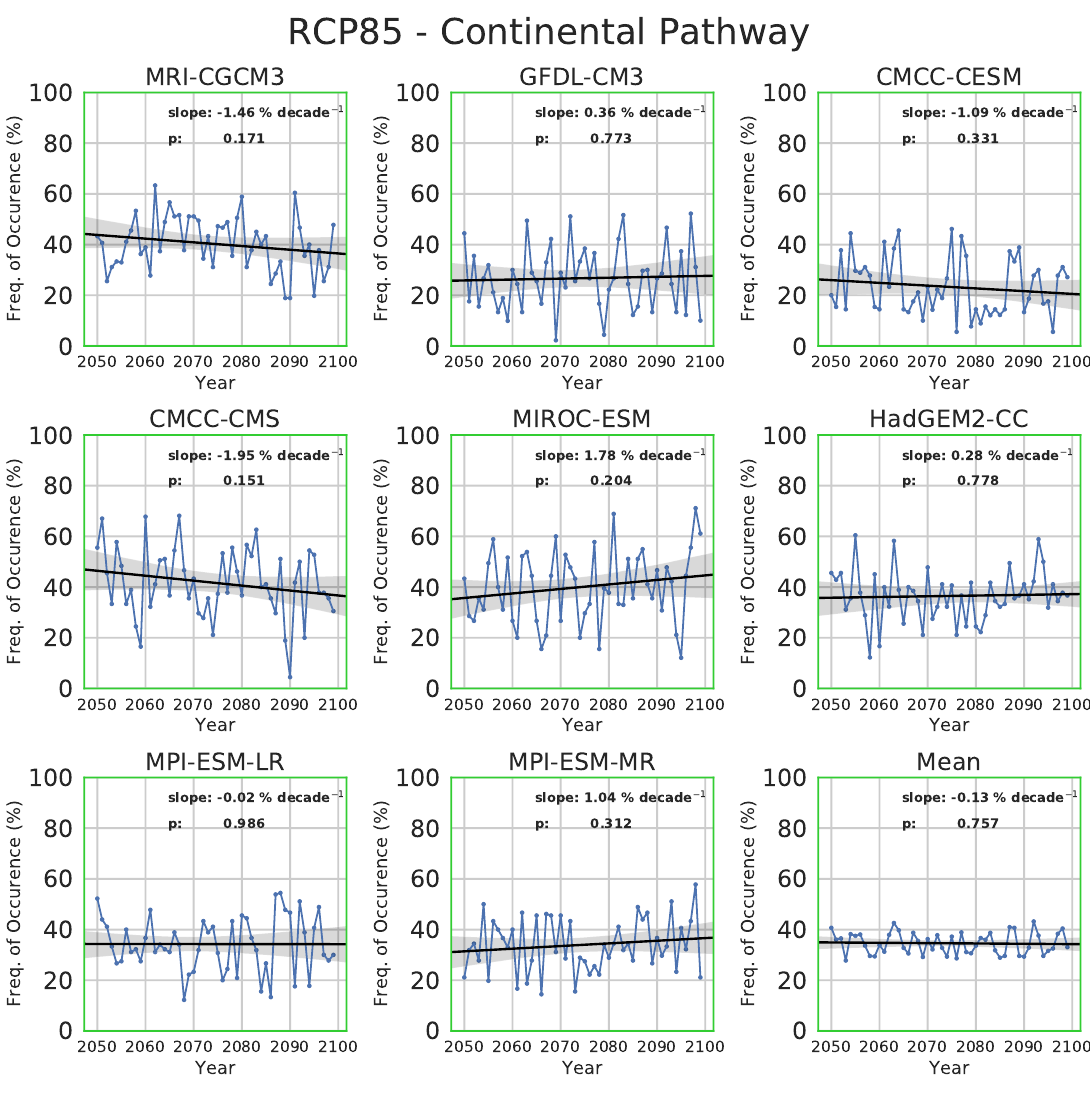
Figure 12. Same as in Figure11, but for the Continental